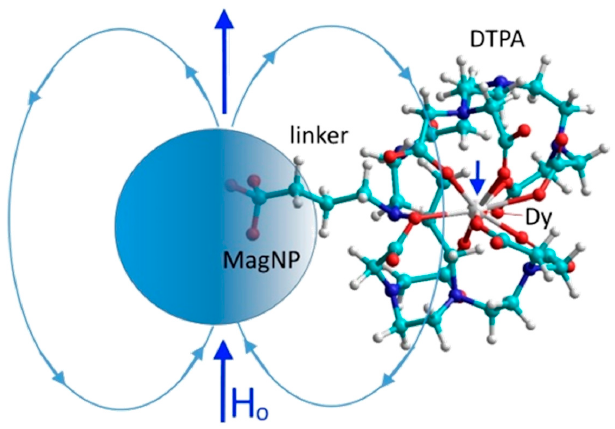
Figure 15. A pictorial representation of the antiferromagnetic dipolar interaction between dysprosium ions and the magnetic nanoparticles (adapted with permission from [35]).